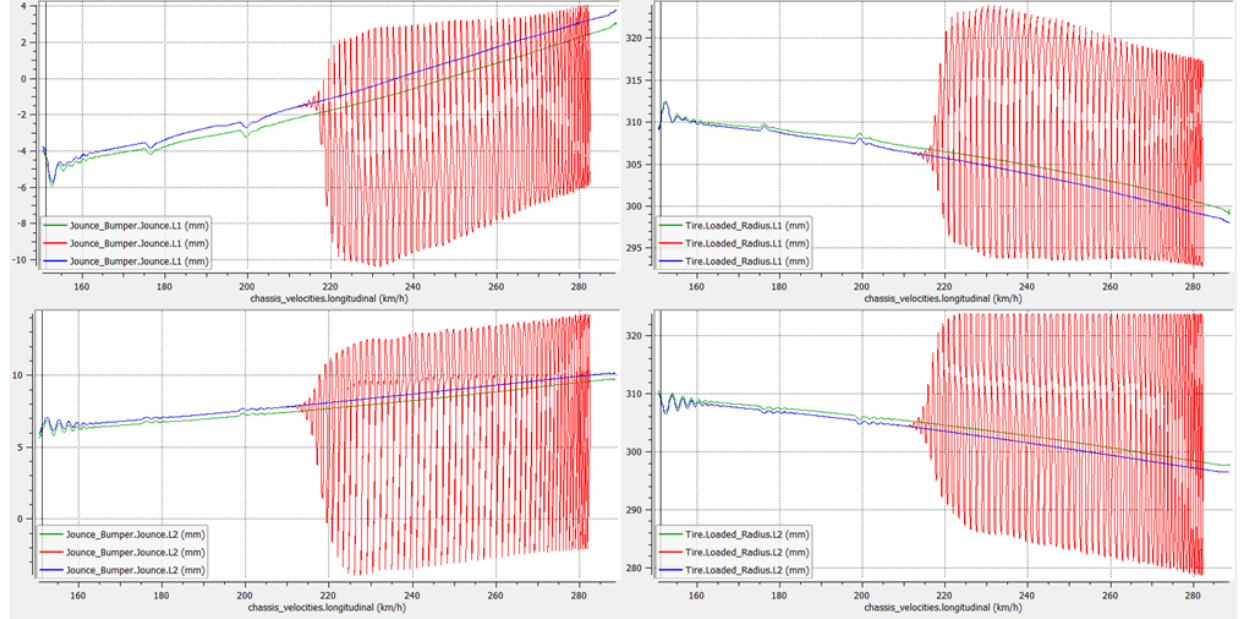
Figure 30. Porpoising is fully removed with Setup #4 (green), in terms of suspension motion ( left plots for front and rear axle) and of tire deflection ( right plots for front and rear axle).